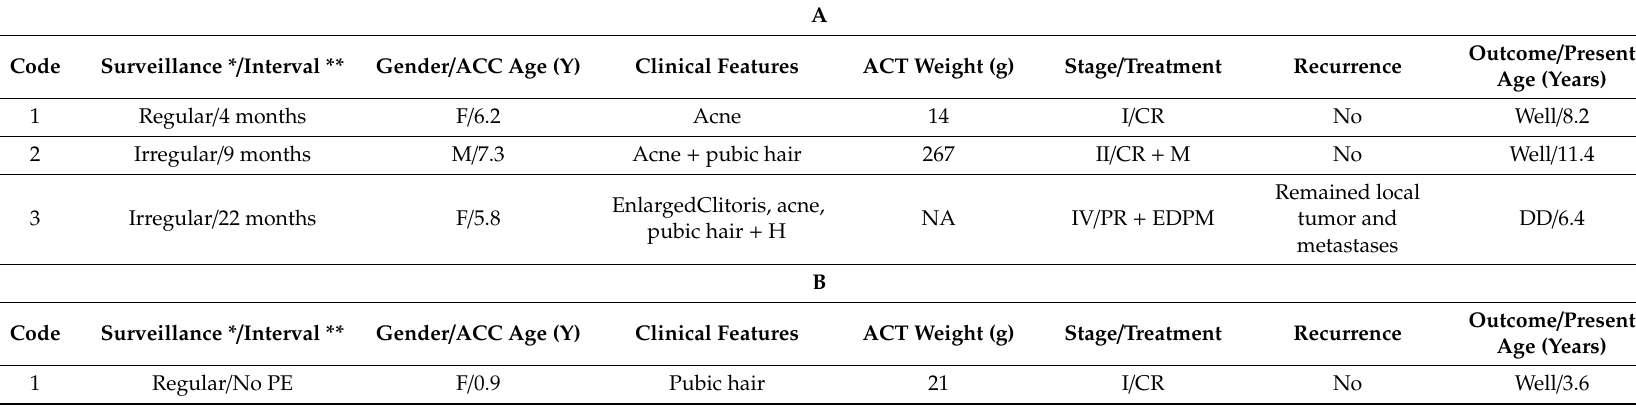
Table 3. ACT cases among R337H carriers: three cases in the 2006-C cohort between 2012 and 2018 with exams ( A ), and one adrenocortical carcinoma (ACC) case in 2016-C without periodical exams (PE) ( B